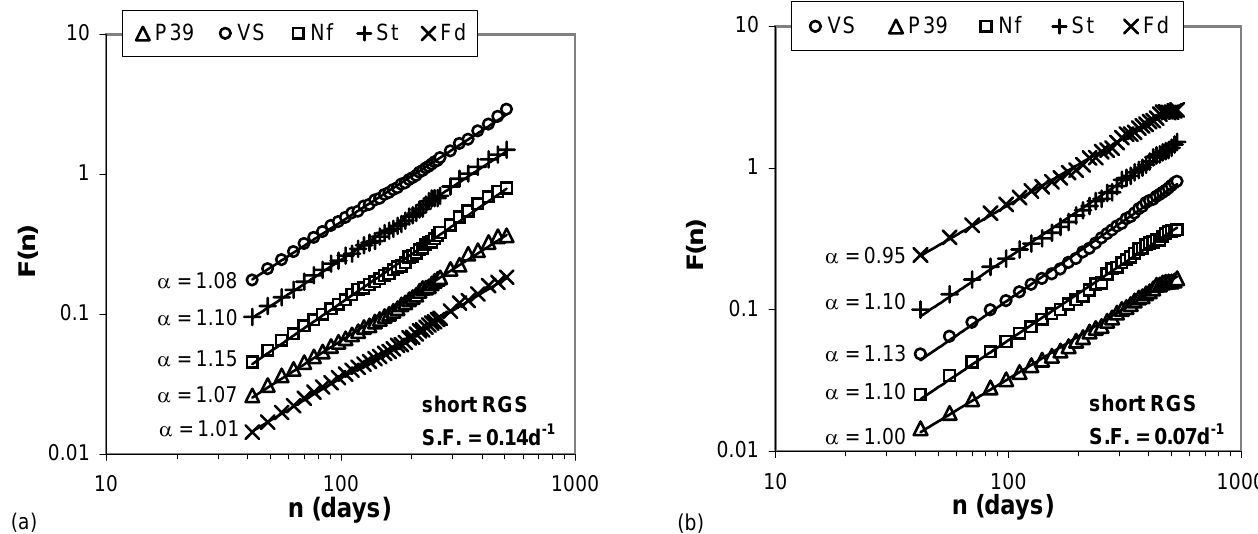
Fig. 11. Log-log plot of F(n) vs. n , for the RGS from all five sites. Before DFA, the RGS from Nf, P39 and VS were shortened so as to